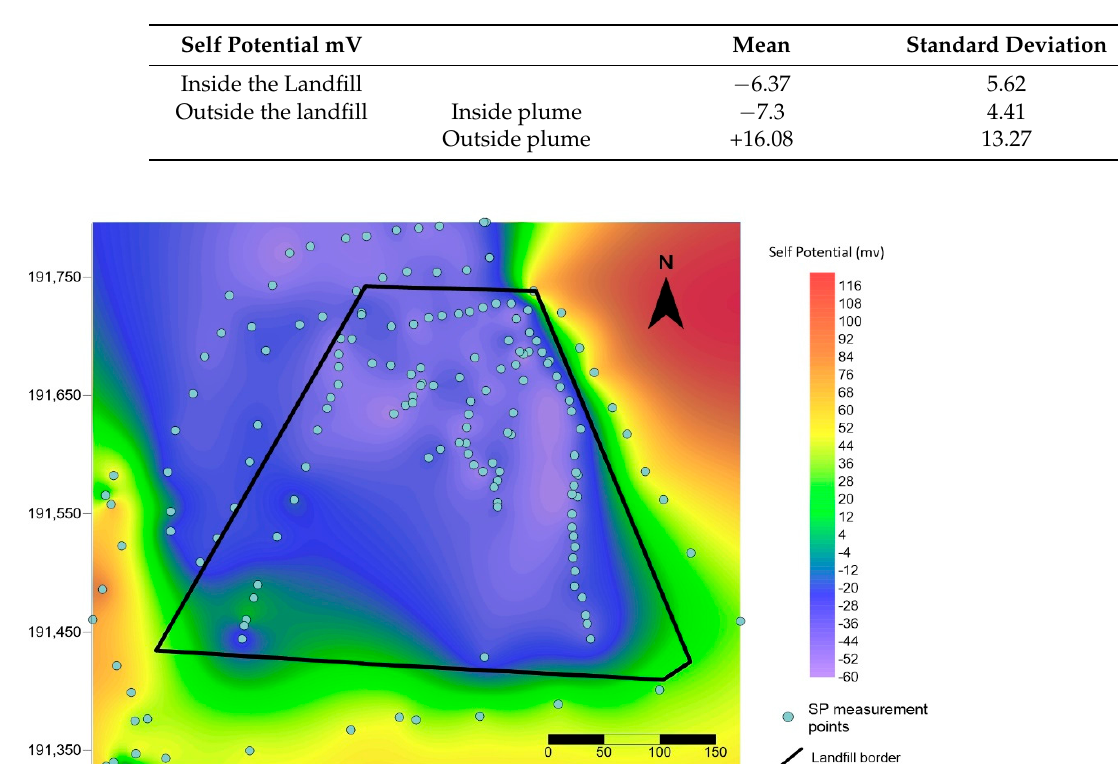
Table 1. Mean SP Values and standard deviation inside and outside the landfill.